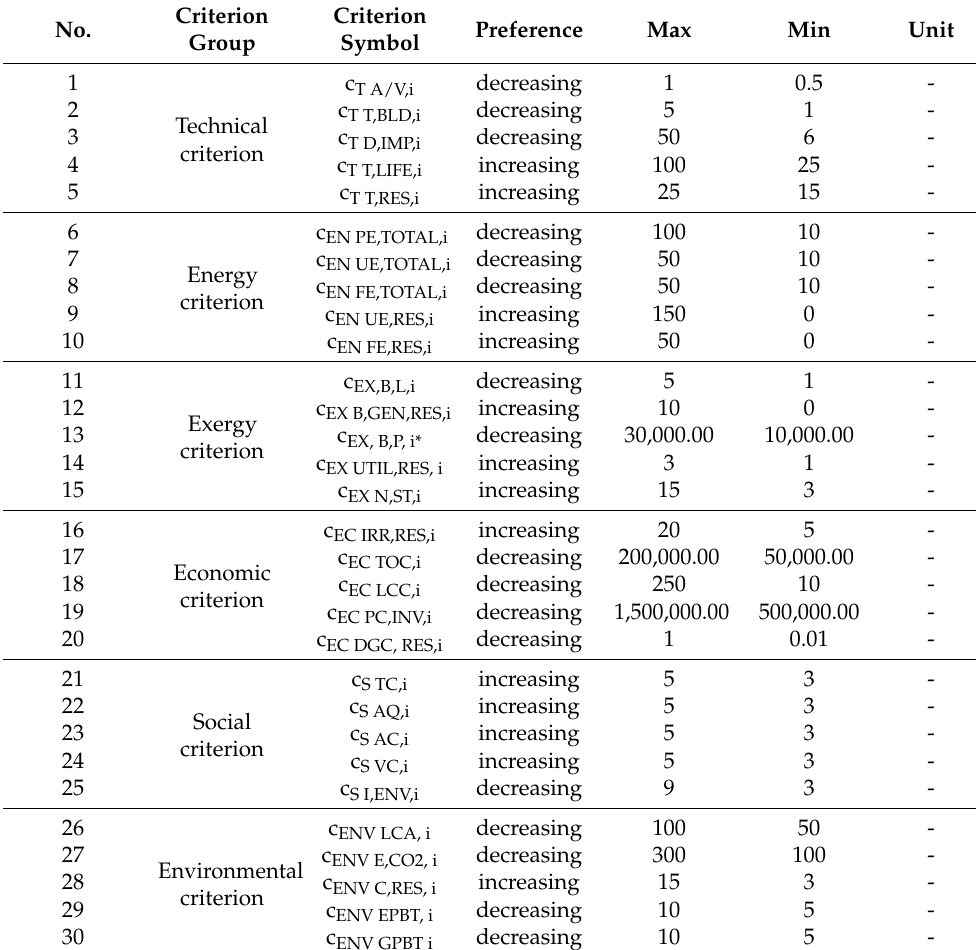
Table 8. Permissible numerical values of indicators for selected evaluation